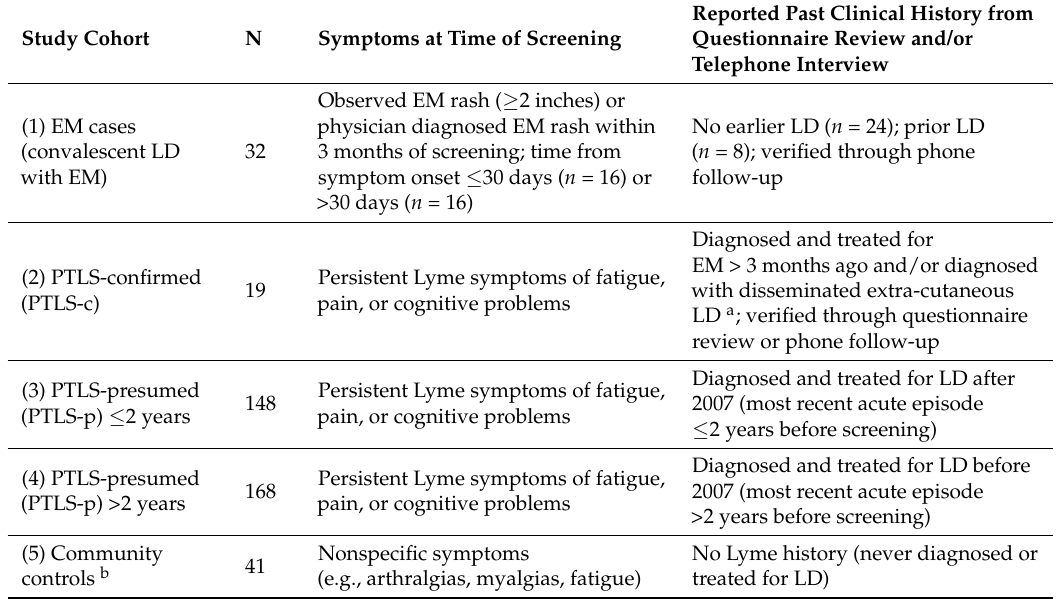
Table 1. Study cohort criteria in Lyme-endemic communities, July